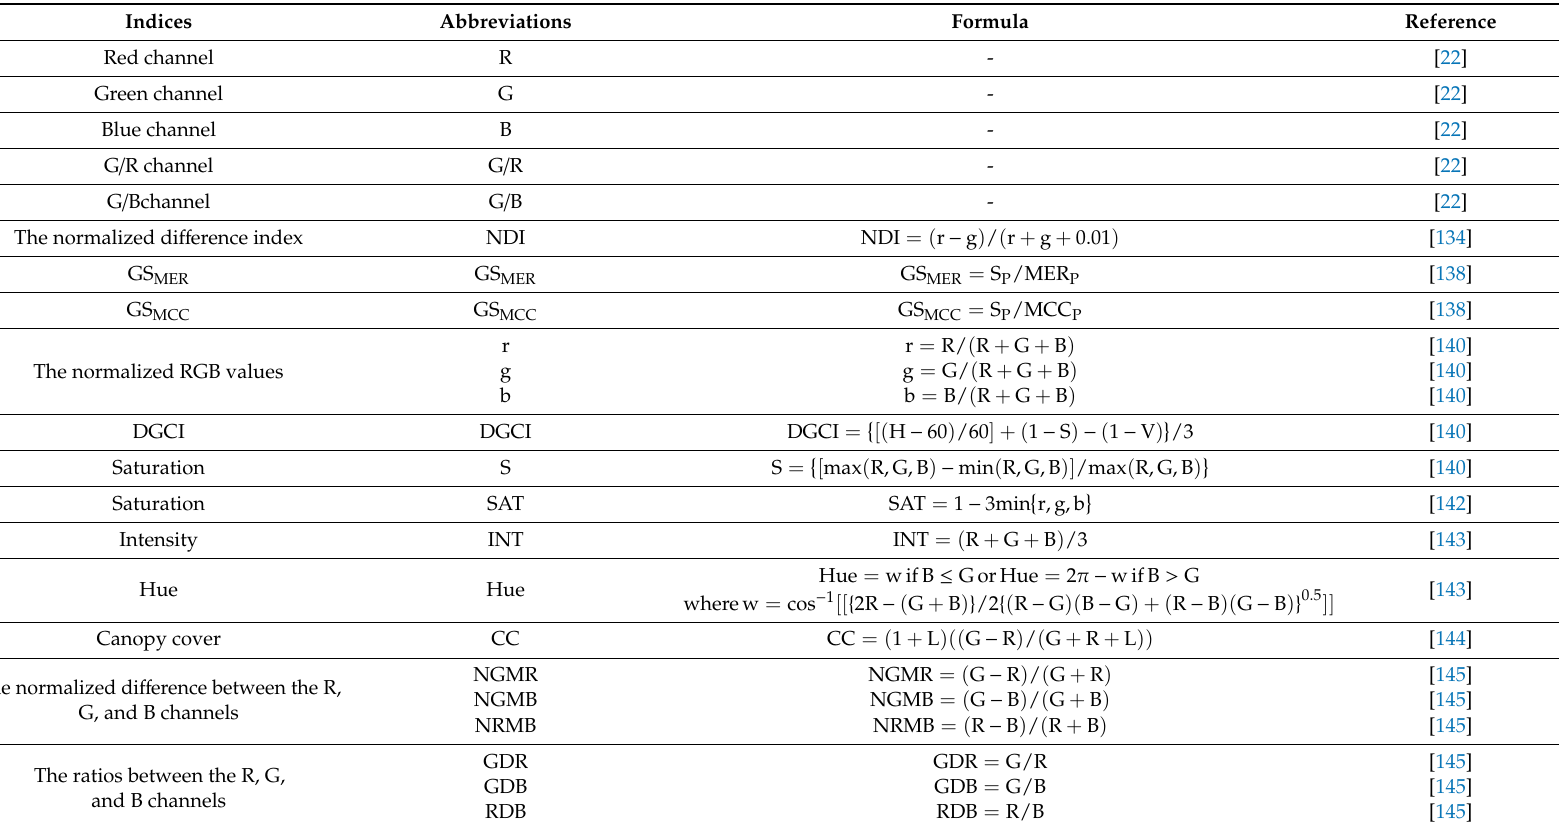
Table 3. Summary of di ff erent image feature for diagnosis of the N